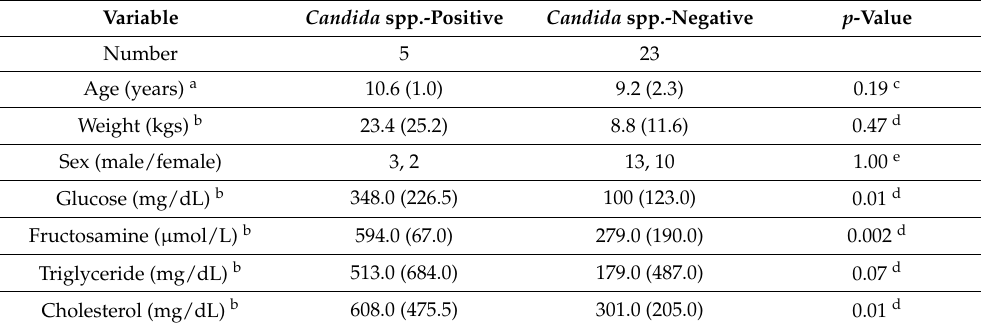
Table 5. Comparative descriptive and clinicopathologic features of diabetic and non-diabetic control dogs with and without Candida spp. colonization from fecal